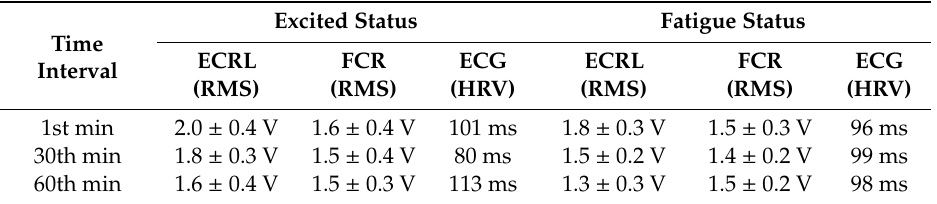
Table 1. Physiological data of a subject in di ff erent time